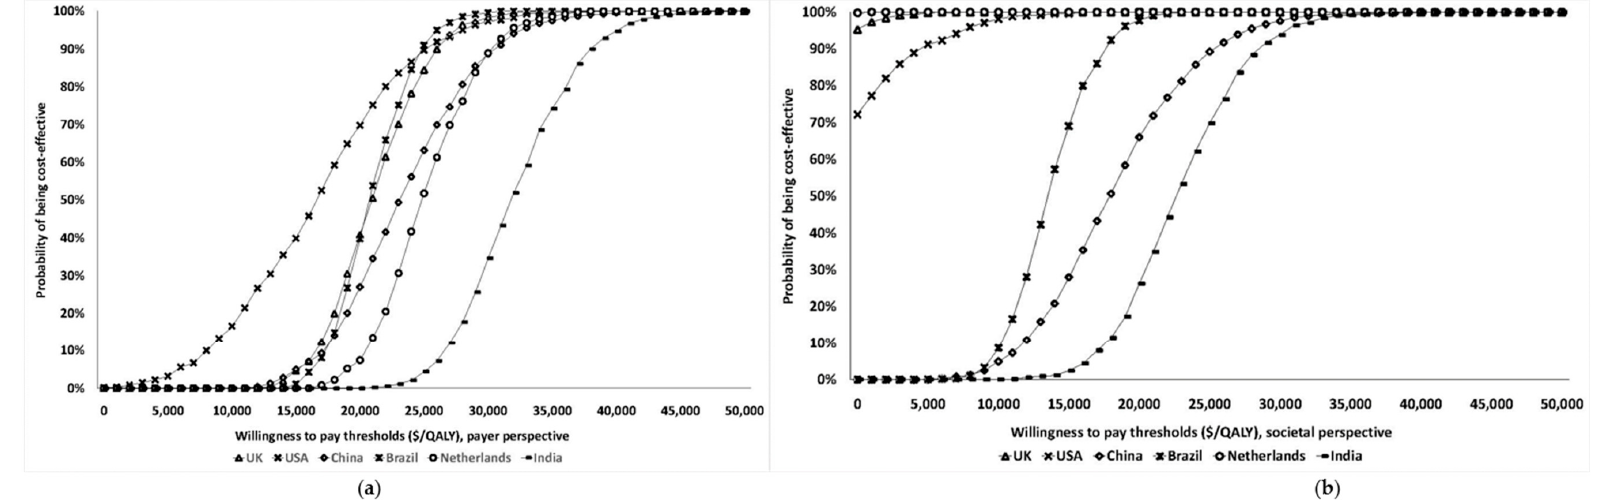
Figure 2. Cost-effectiveness acceptability curves. ( a ) Cost-effectiveness acceptability curve—payer perspective. ( b ) Cost-effectiveness acceptability curve—societal perspective. * The GDP-based (WHO) willingness-to-pay thresholds are $127,969 / QALY in the UK, $172,766 / QALY in the US, $151,616 / QALY in the Netherlands, $46,592/QALY in China, $45,545/QALY in Brazil, and $19,722/QALY in India (Table 2). The country guideline-specific willingness-to-pay thresholds are $42,857/QALY in the UK, $100,000 in the US, and $60,976 in the Netherlands (Table 2). Probabilistic sensitivity analysis in which all model parameters/variables are varied simultaneously across their distributions to further explore model uncertainty. X-axis: Willingness-to-pay thresholds in terms of Cost ($s))/QALY; Y-axis: Proportion of simulations. The results of 1000 simulations were plotted on a cost-effectiveness acceptability curve showing the proportion of simulations (Y-axis) that indicated that the intervention was cost-effective at different willingness-to-pay thresholds (X-axis). Separate curves are plotted for the UK, USA, Netherlands, China, Brazil, and India, with different analyses provided for both payer (Figure 2a) and societal (Figure 2b) perspectives.